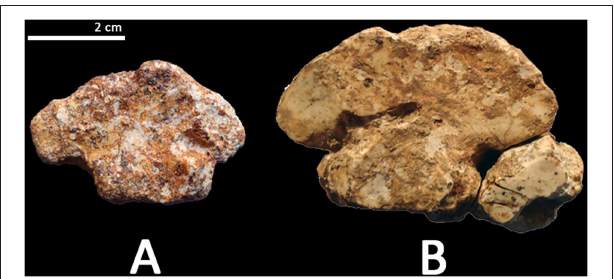
FIGURE 5 | Equus altidens (A) and Equus cf. suessenbornensis (B) from Bois de Riquet (US2). (A) Right proximal metacarpal (BDR-X37b-61b); (B) left proximal metacarpal